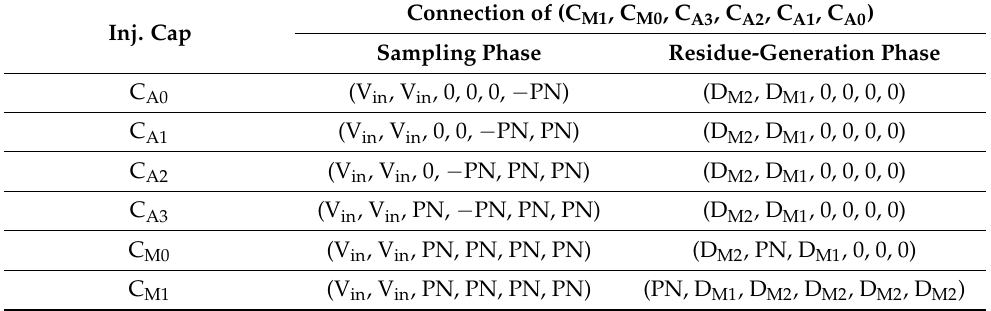
Table 1. PN Injection in the First Stage CDAC. Inj. Cap Inj.